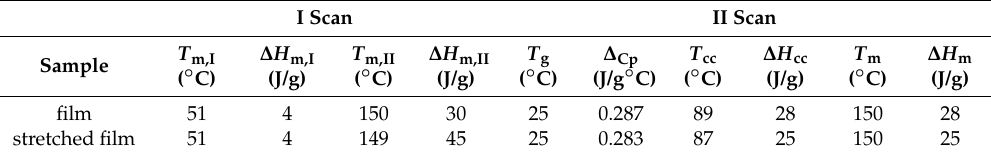
Table 1. I and II calorimetric scan data of PBTF film and stretched